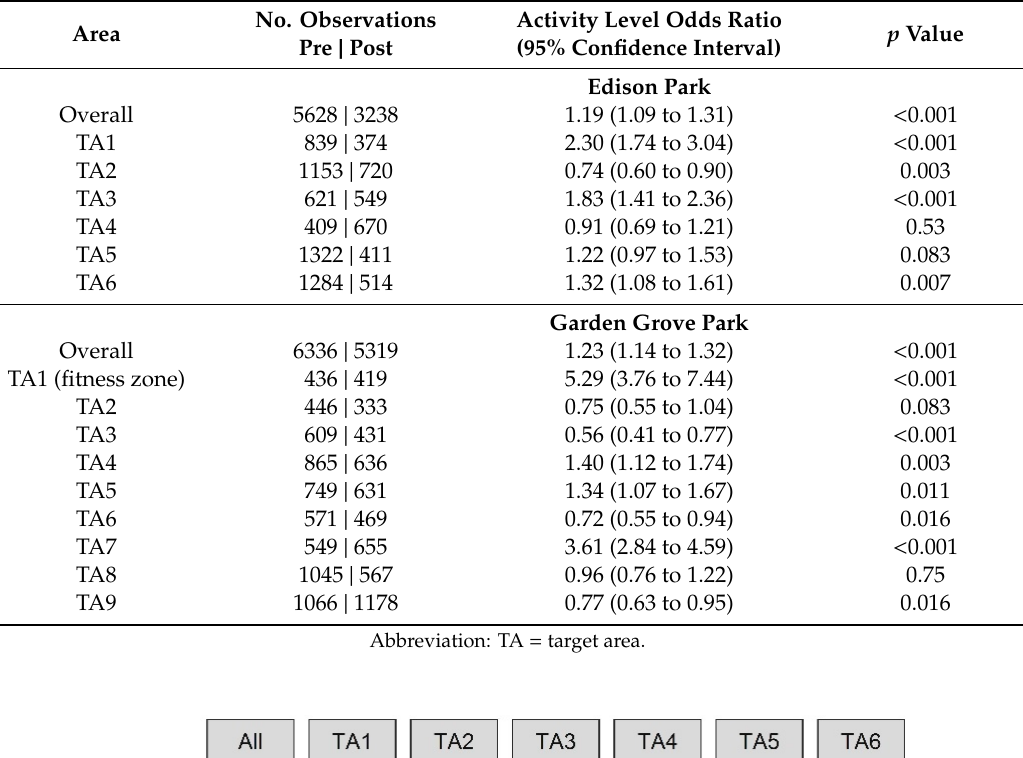
Table 2. Odds of higher physical activity levels post-intervention relative to pre-intervention.